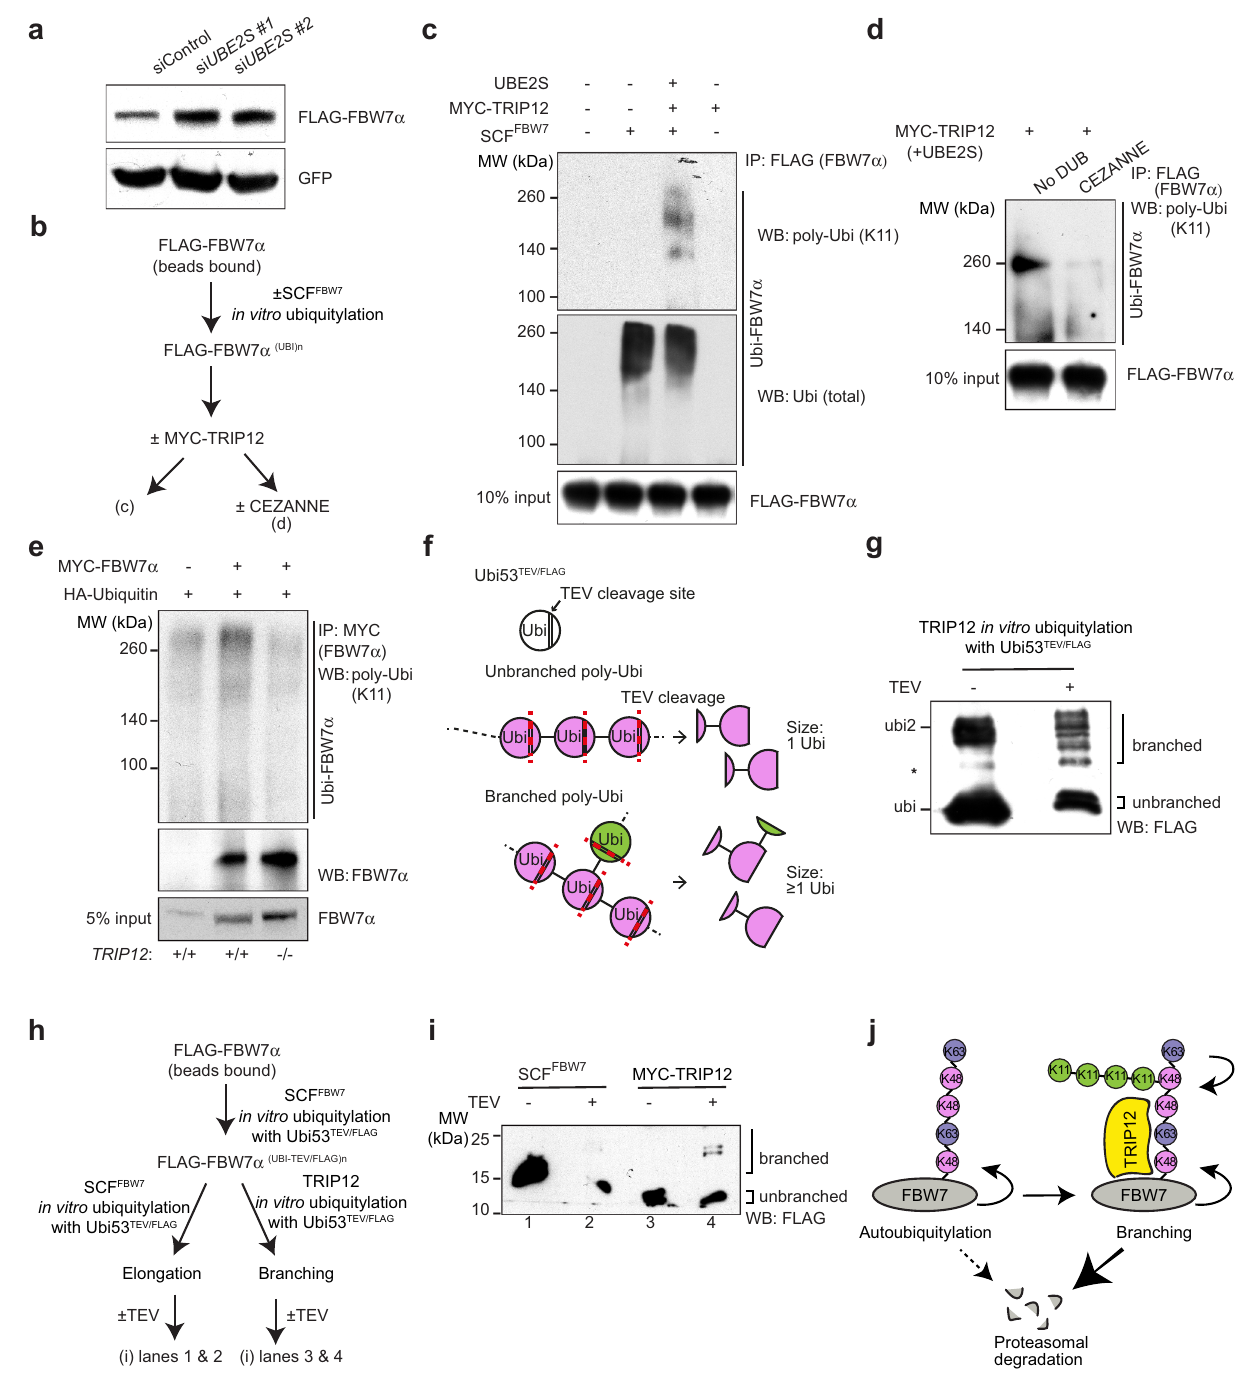
Fig. 7 TRIP12 and UBE2S catalyse-branched ubiquitylation of FBW7. a Western blots showing levels of FLAG-FBW7 protein in HEK293T cells incubated with a control and two independent siRNAs targeting the K11-linkage-speci fi c E2 enzyme, UBE2S . b Schematic of sequential in vitro ubiquitylation assay followed by Cezanne-mediated K11-linkage cleavage. Ubiquitylation step 1: SCF FBW7 + UBCH5 + wt-ubi; step 2: TRIP12 + UBE2S + K48R-ubi. c Western blots showing FBW7 in vitro ubiquitylation and K11-linkage addition by TRIP12. d Con fi rmation of K11-linkage on FBW7 by TRIP12 with a K11-speci fi c deubiquitinase, Cezanne. e Western blots showing enrichment of K11-linked polyubiquitylated FBW7 in HEK293T cells of the indicated genotypes. f Outline of the method to detect branched ubiquitylation. g Western blots con fi rming branching activity of TRIP12-HECT domain in vitro, black star (*) represents a nonspeci fi c band of unknown identity. h Schematic for FBW7 in vitro branched ubiquitylation assay. i FBW7-branched ubiquitylation by TRIP12 using the Ubi53TEV/FLAG mutant followed by TEV cleavage and blotting with FLAG-M2-HRP antibody. j Outline of the potential mechanism regulating FBW7 proteasomal degradation. See also Supplementary Fig. 5. All blots are representative of at least three independent experiments. Source data are provided as a Source Data fi